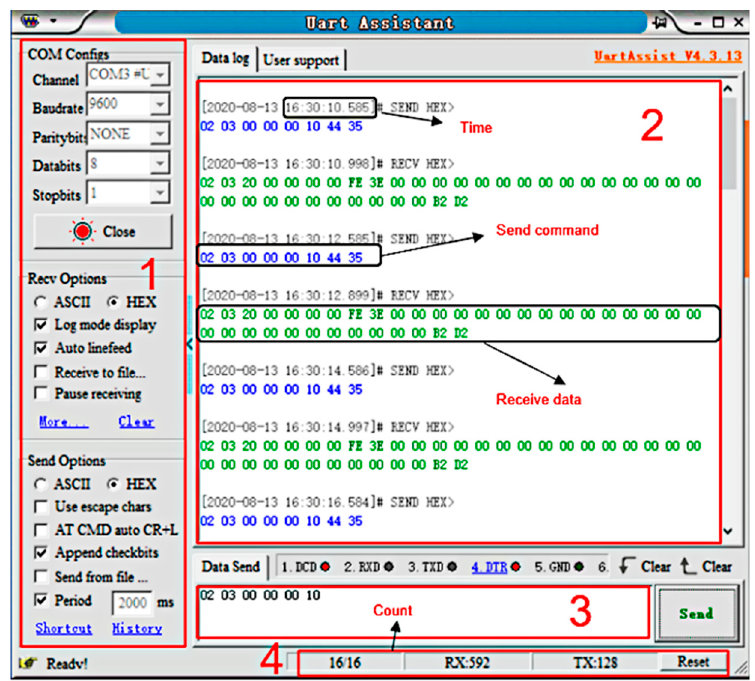
Figure 5. Measurement software *. * location: http://www.cmsoft.cn/resource/101.html; company: